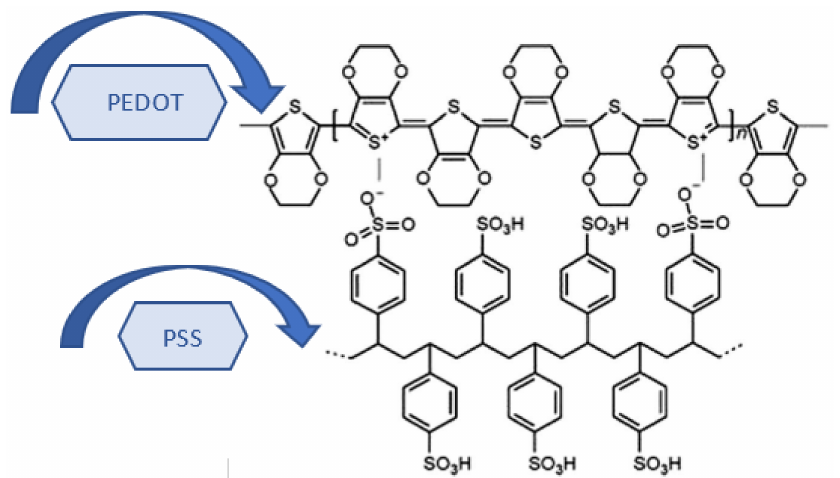
Figure 2. PEDOT:PSS chemical